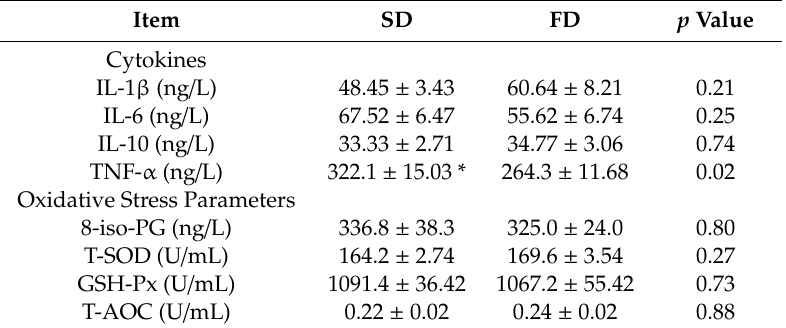
Table 3. E ff ect of the maternal diet with fish oil on the immune cytokines and oxidative stress parameters in the plasma of sows.